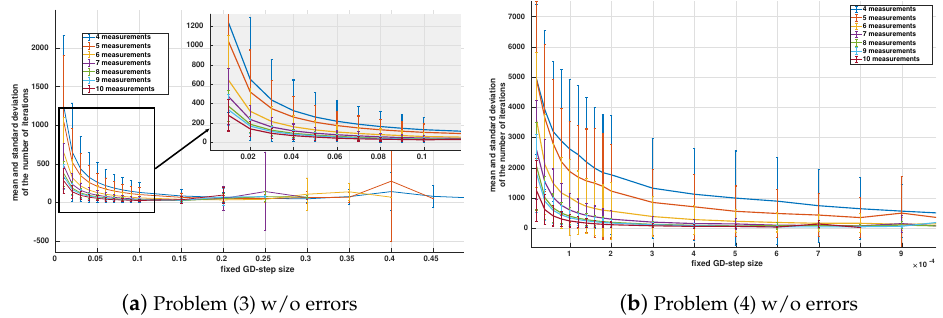
Figure 3. Mean number of iterations to convergence with standard deviation on 10,000 simulations using GD with fixed-step descent for estimation problems (3) ( a ) and (4) ( b ), respectively, with- out explicitly considering position and measurement error models and by varying the number of neighboring nodes from 4 to 10.